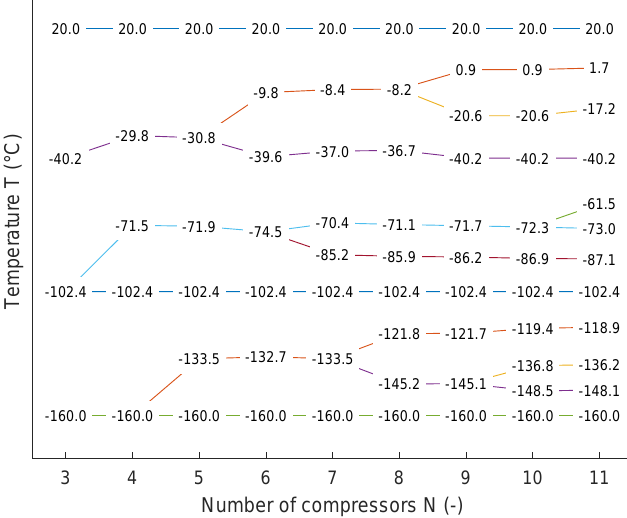
Figure 9. Temperature settings for the most energy-efficient cascade process with N compressor stages at T 0 = 20 ◦ C.